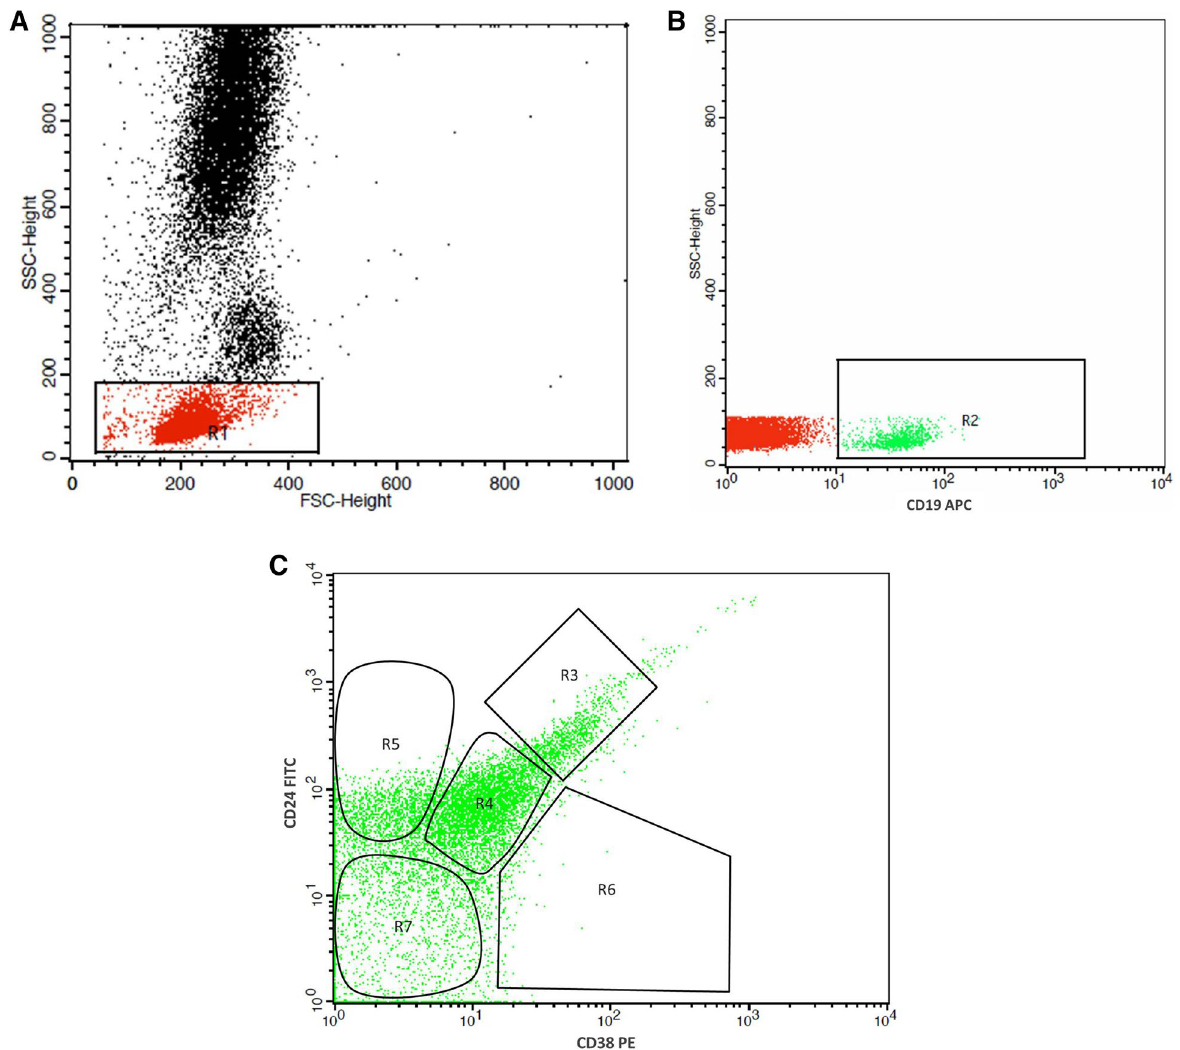
Figure 1. Flow cytometry analysis of B cell subsets. A The lymphocyte population was defined within the PBMCs on the forward and side scatter plot by drawing (R1). B The expression of CD19 on lymphocytes was identified, then CD19 + cells were gated through (R2) for further analysis of CD24 and CD38. C The percentages of B cell subsets [CD24 hi CD38 hi , CD24 int CD38 int , CD24 + CD38 − , CD24 − CD38 + and CD24 − CD38 − B cells] were calculated by drawing the regions (R3), (R4), (R5), (R6) and (R7),